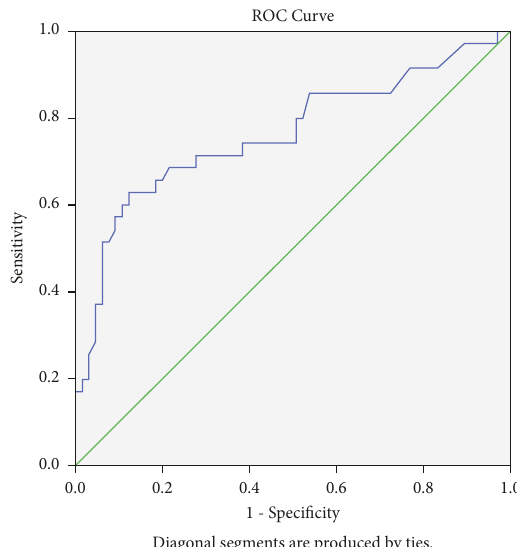
Figure 1: Receiver operating curve for salivary glucose levels with total area under curve 0.76 with a sensitivity of 71.4% and specificity of